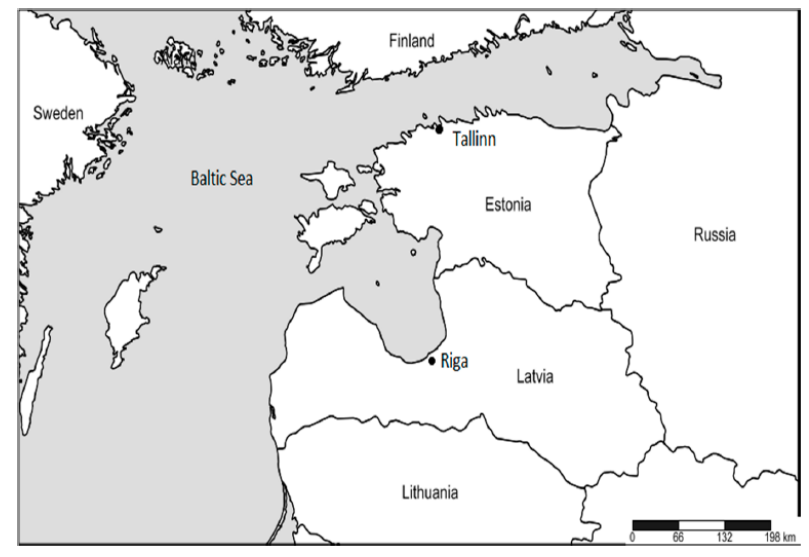
Figure 1. The study area and neighboring countries. [27].